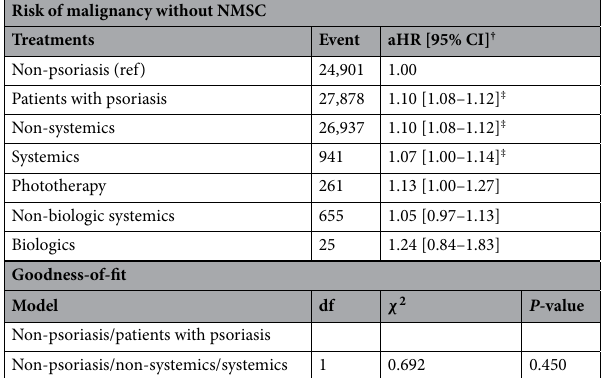
Table 2. Risk of malignancy without NMSC in patients with psoriasis according to anti-psoriasis treatments compared with in non-psoriasis participants and their goodness-of-fit statistics. † Adjusted for age, sex, BMI, smoking status, family history of malignancy, Charlson Comorbidity Index, and alcohol use disorder (F10). ‡ The null hypothesis was rejected at a significance level of 0.05. aHR, adjusted hazard ratio; BMI, body mass index; CI, confidence interval; NMSC, nonmelanoma skin cancer; ref,